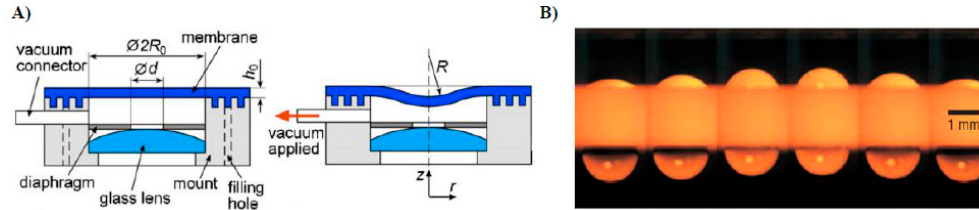
Figure 2. ( A ) Oscillating liquid lens under a forcing amplitude of 5.5 Pa. Reprinted from Kyle, C.; Fainman, Y.; Groisman, A. Pneumatically actuated adaptive lenses with millisecond response time.